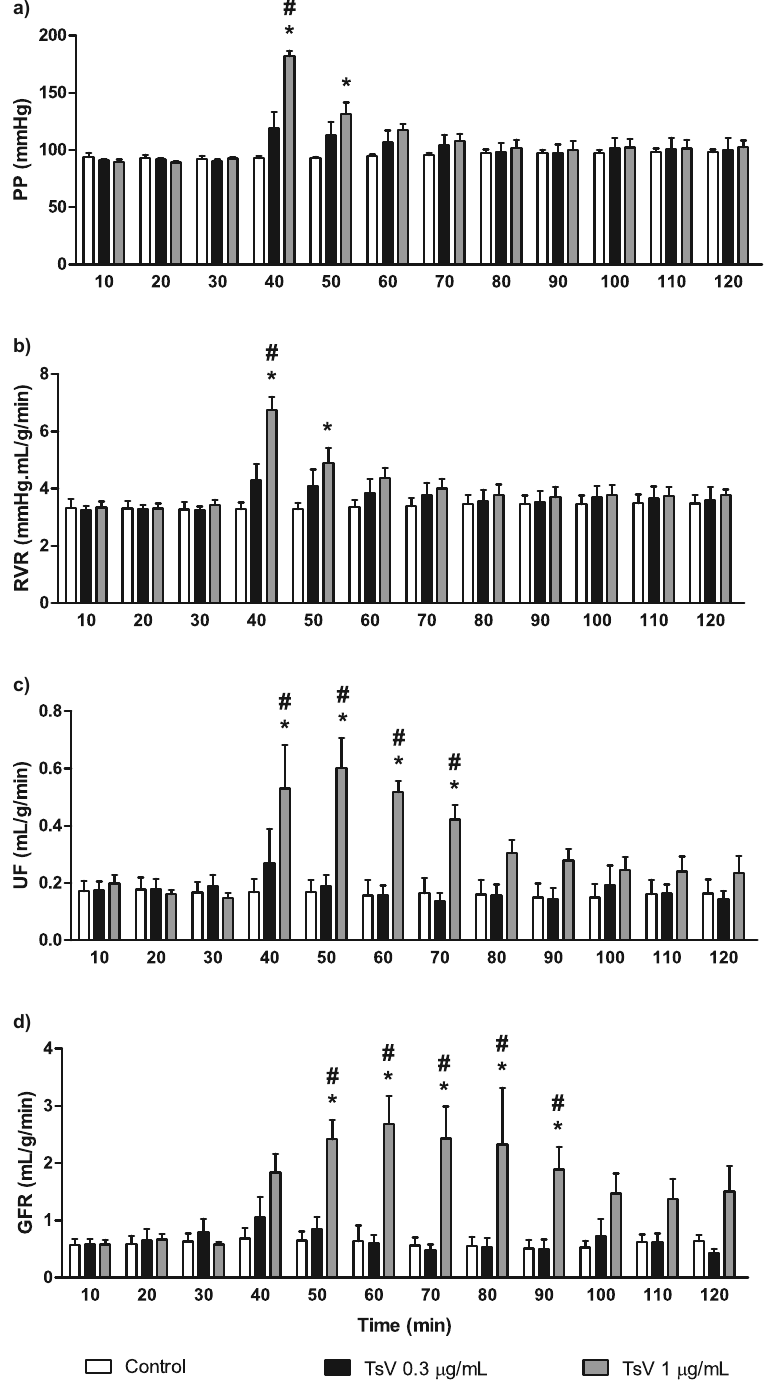
Figure 2 - Effect of Tityus stigmurus venom (TsV) on perfusion pressure (a) , renal vascular resistance (b) , urinary fl ow (c) , and glomerular fi ltration rate (d) . Data are expressed as mean ± SEM from six different animals and were analyzed by ANOVA followed by Bonferroni test. *p < 0.05 compared with the corresponding external control group for each interval. # p < 0.05 compared with the group treated with 0.3 μ g/mL for each